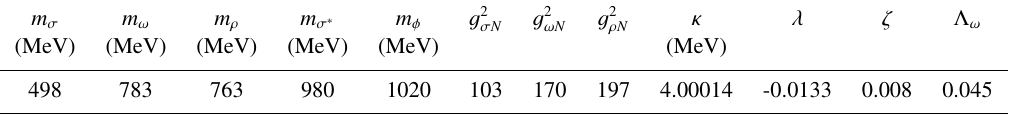
Table 1. Parameters of the model FSU2H*. The mass of the nucleon is equal to m N = 939 MeV. m σ m ω m ρ m σ ∗ m ϕ g 2 g 2 g 2 κ λ ζ Λ ω σ N ω N ρ N (MeV) (MeV) (MeV) (MeV) (MeV) (MeV) 498 783 763 980 1020 103 170 197 4.00014 -0.0133 0.008 0.045 Table 2. The ratios of the couplings of hyperons to mesons with respect to the nucleonic ones. Y R σ Y R ω Y R ρ Y R σ ∗ Y R ϕ Y −√ Λ 0 . 6613 2 / 3 0 0 . 2812 2 / 3 −√ Σ 0 . 4673 2 / 3 1 0 . 2812 2 / 3 √ Ξ 0 . 3305 1 / 3 1 0 . 5624 − 2 2 / 3